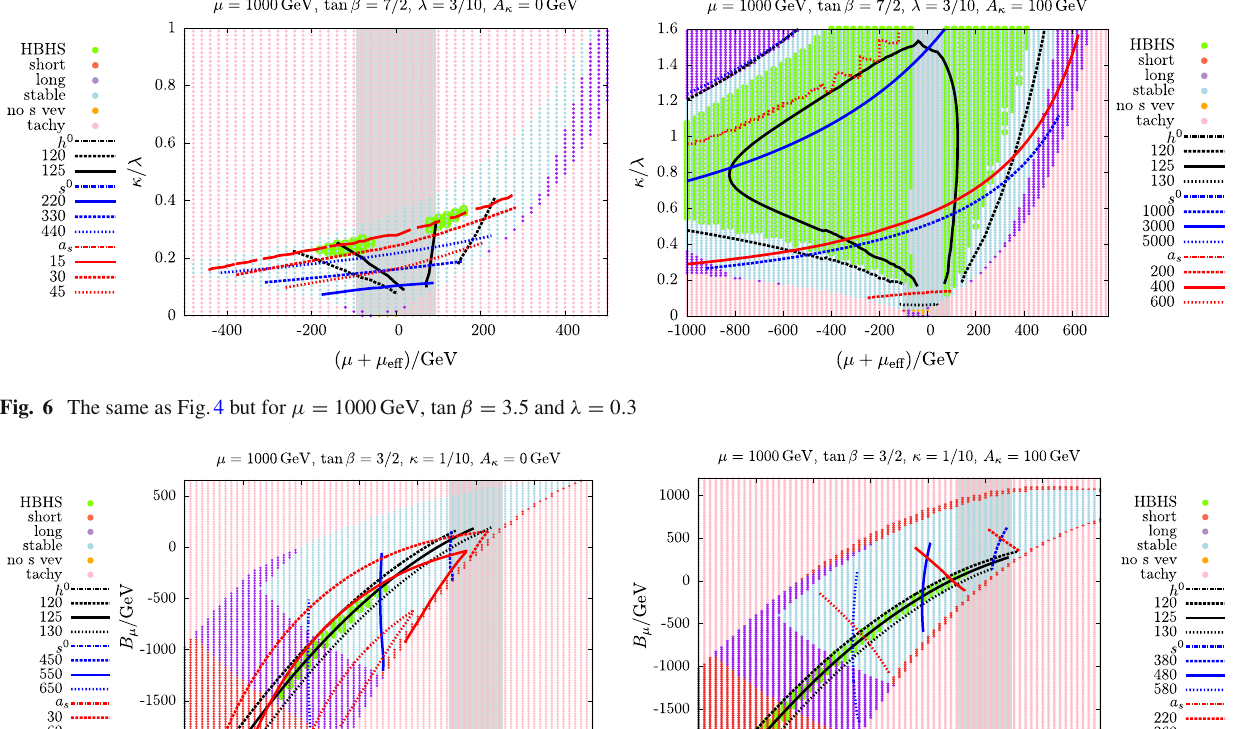
Fig. 7 Dependence of mass contours and vacuum stability, see Fig.4 for an explanation of the color code, on the Z 3 -breaking soft SUSY- breaking B μ term and (μ + μ eff ) for λ = 0 . 5. On the left-hand side, the value A κ = 0GeV was chosen, while on the right A κ = 100GeV